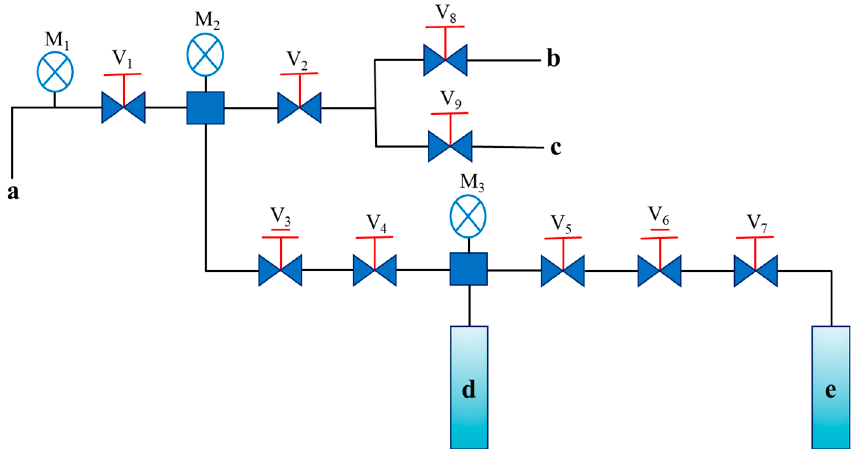
Figure 10. Experimental apparatus of methane adsorption: a–methane cylinder; b–vacuum pump; c–vent; d–reference tank in a thermostatic bath; e–adsorption tank in a low ‐ temperature bath; V 1 , V 2 , V 4 , V 5 , V 7 ∼ 9 –cutoff valve; V 3 , V 6 –metering valve; M 1 , M 2 –pressure gauge; M 3 –pressure sensor.